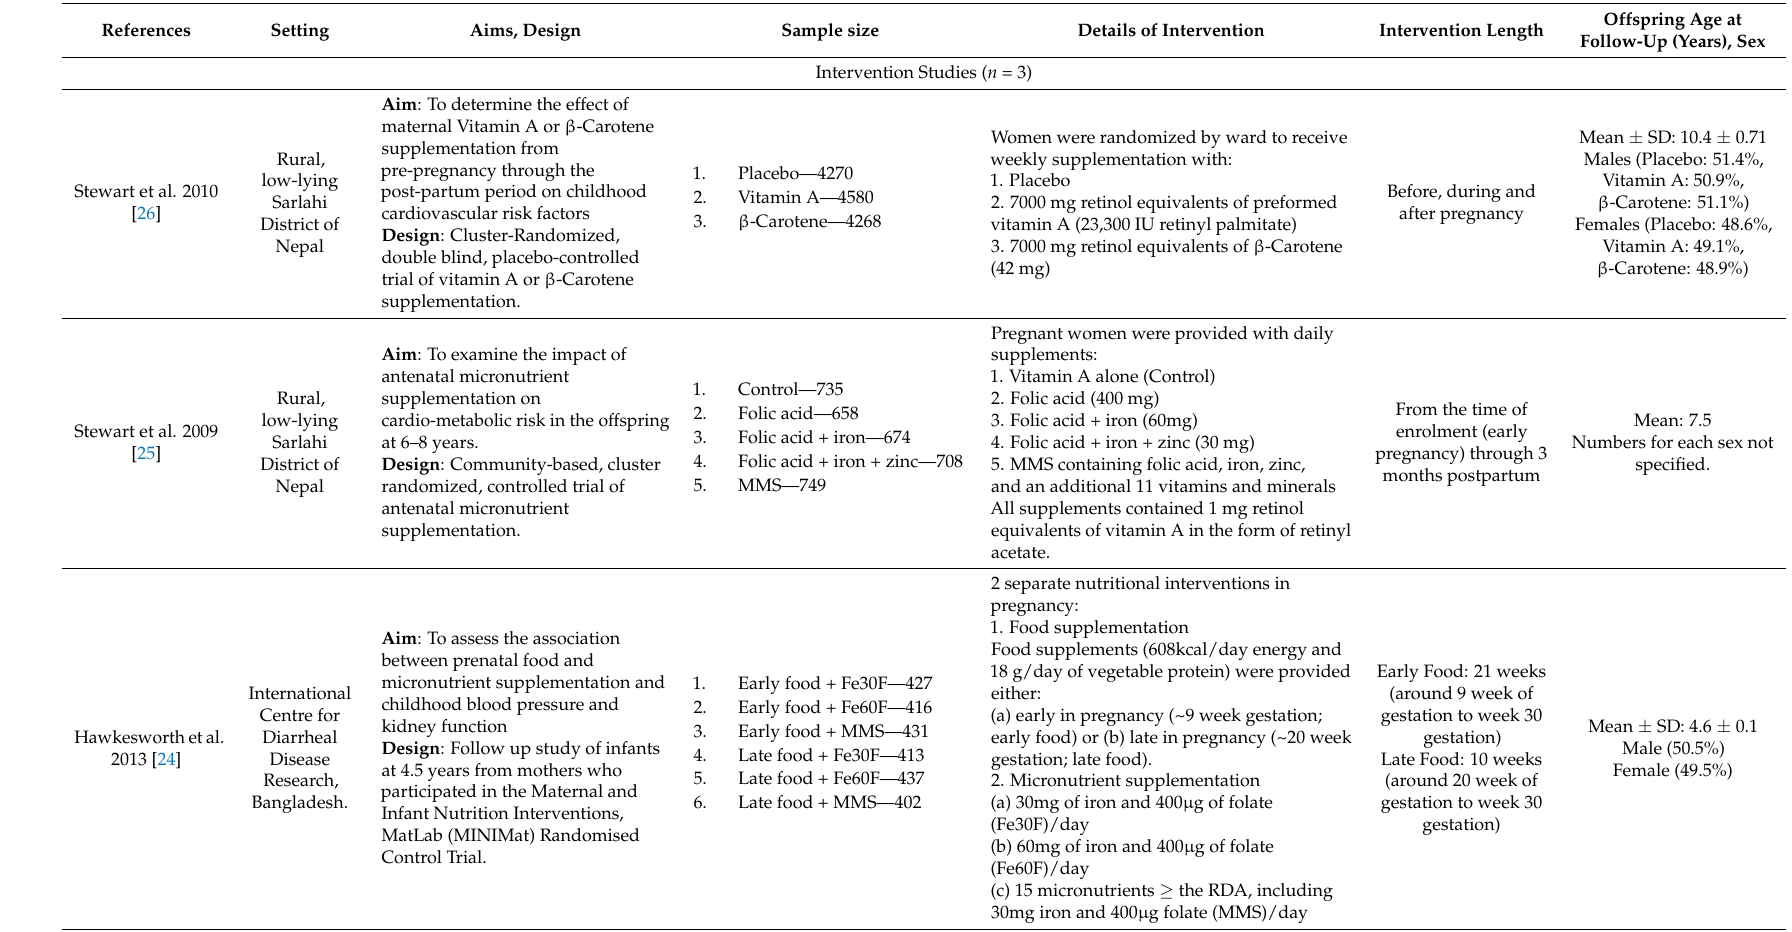
Table 1. Description of intervention